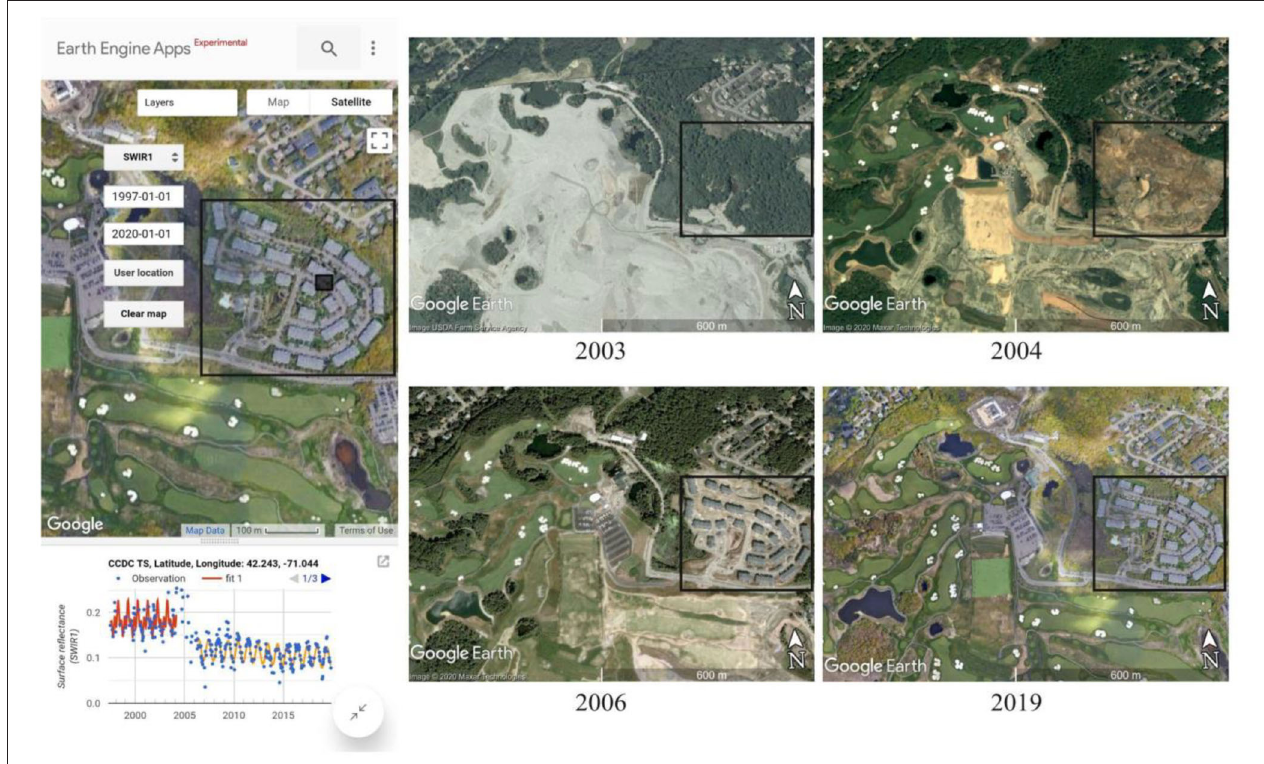
FIGURE 7 | Left panel: interface of the Simple time series viewer as seen in a mobile phone. The smaller square shows the clicked location on the map, with the corresponding Landsat time series and CCDC segments show below. Right panels: Multi-temporal high-resolution images of the area shown for reference, highlighting the conversion from forested area to